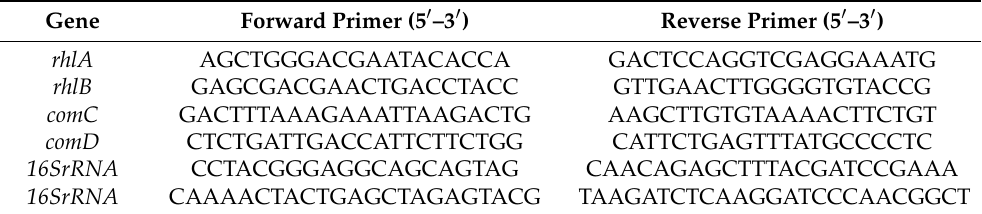
Table 1. qRT-PCR